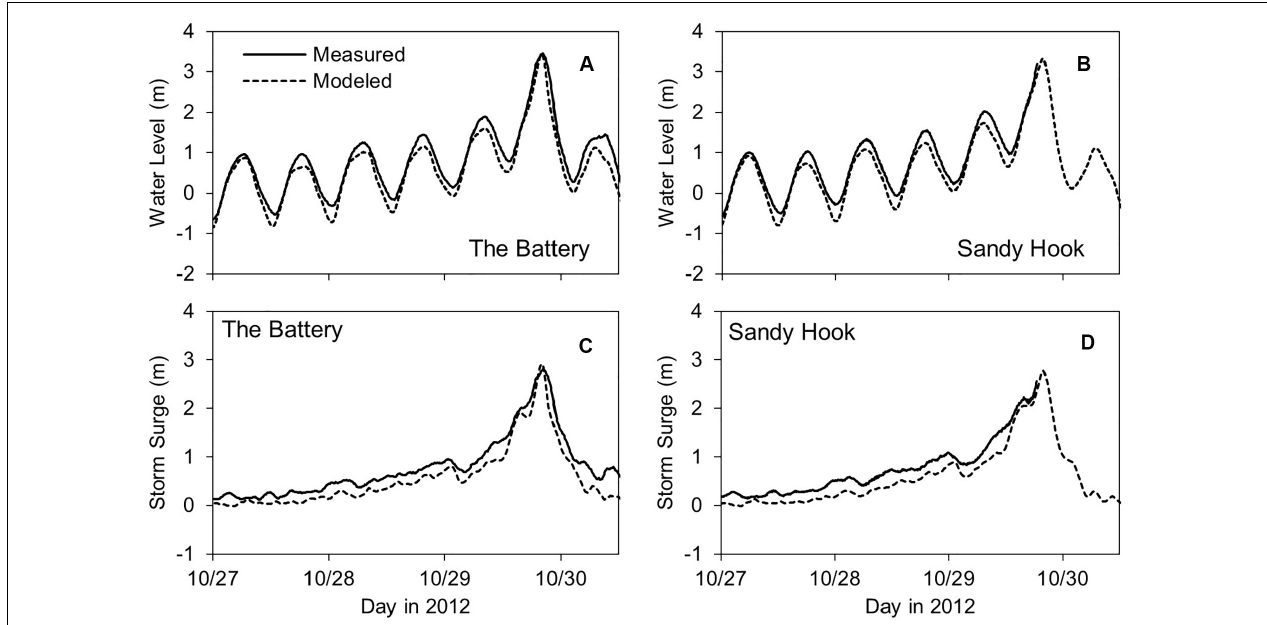
FIGURE 5 | Measured and modeled time series of storm tide (water level) and storm surge at (A , C) The Battery and (B,D) Sandy Hook tide gauge stations. The vertical datum is in mean sea level.